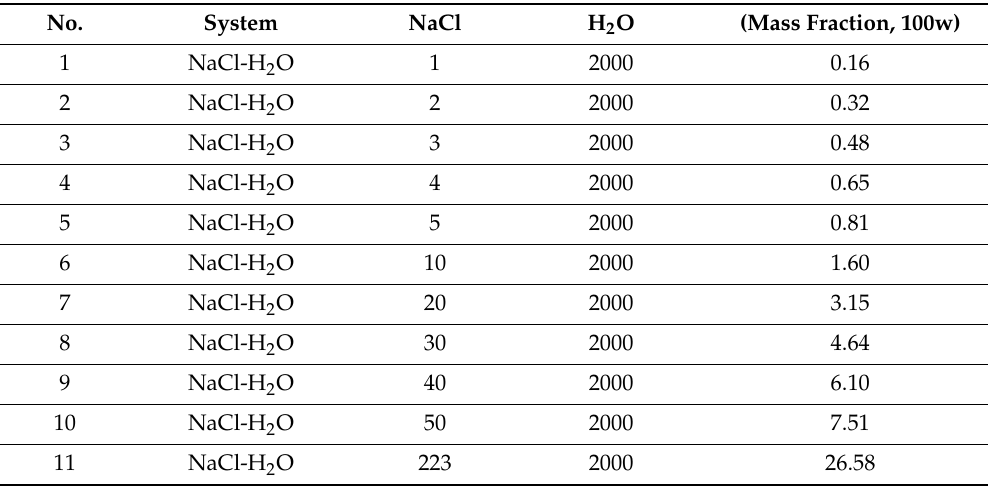
Table 1. The simulated systems in this